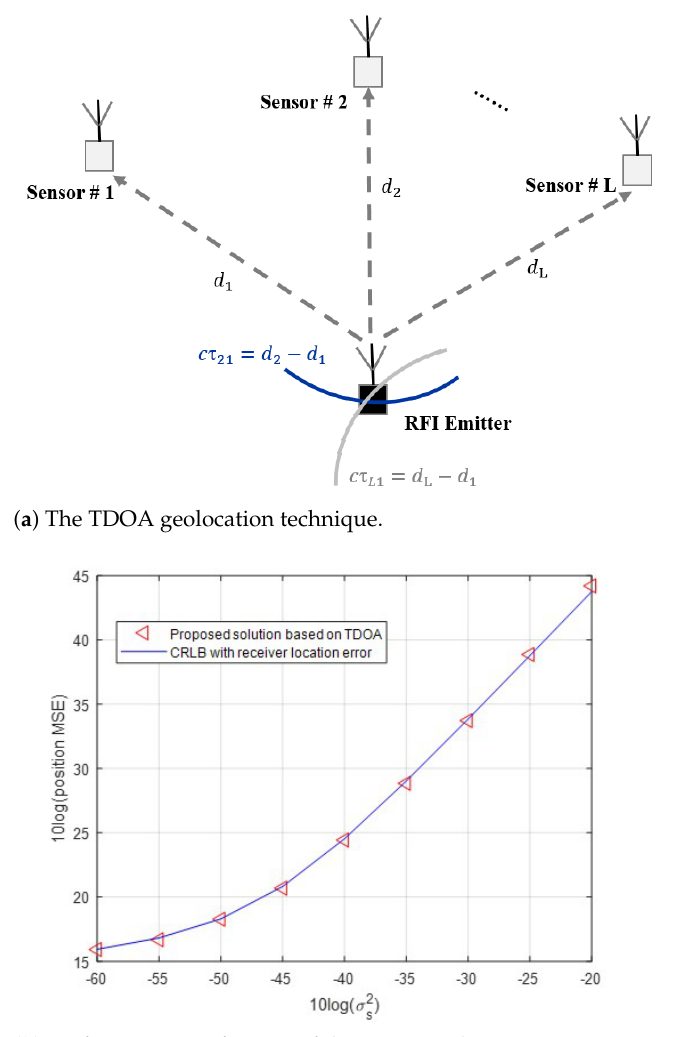
Figure 6. The geometry of the TDOA measurement and the performance of the proposed algorithm verified by CRLB and MSE. From ( b ), it can be noted that the performance of the proposed algorithm is very asymptotical to CRLB